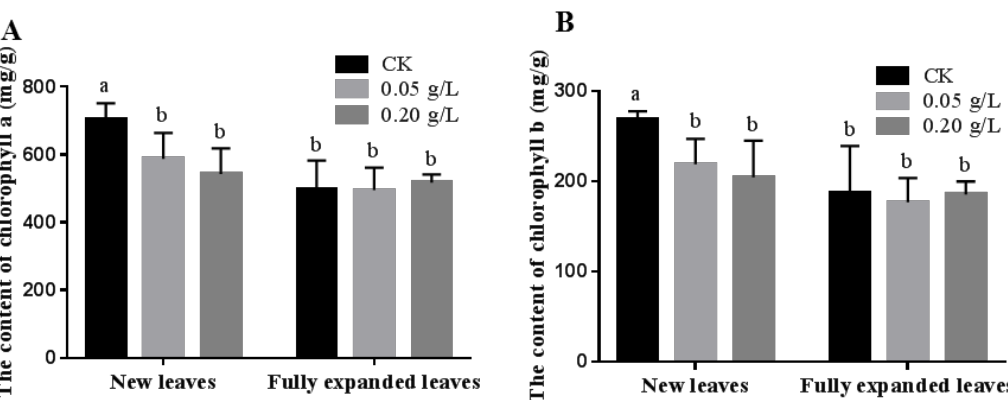
Figure 4. The concentrations of Chlorophyll a ( A ) and b ( B ) in leaves of Brassica napus seedlings under different CMS treatments. CK is a full-strength Hoagland’s solution. Two concentrations (0.05 and 0.20 g L −1 ) of CMS were added to the Hoagland’s solution. Different letters indicate the significant differences at p < 0.05 by Duncan’s test. Data are means ± SD with four biological replicates.